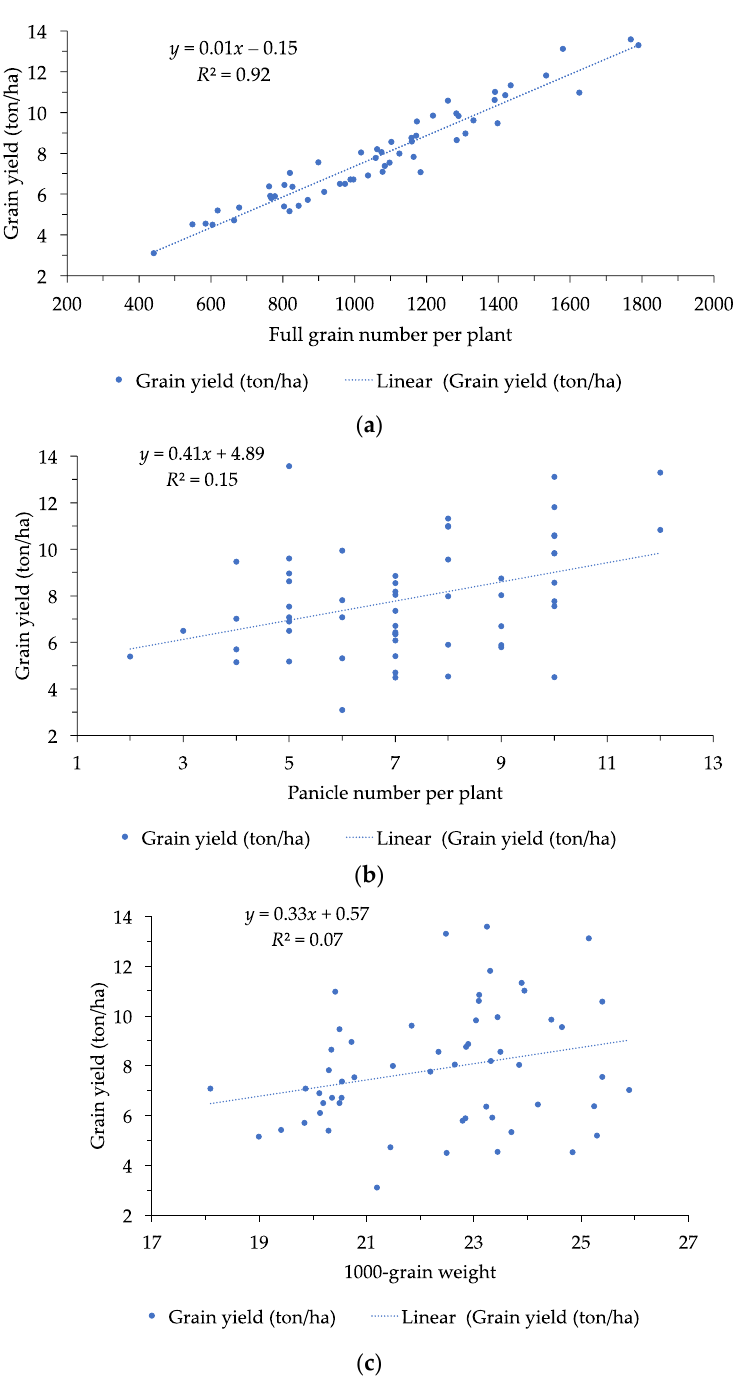
Figure 1. Relationship between grain yield and ( a ) full grain number per plant, ( b ) panicle number per plant, and ( c ) 1000-grain weight.